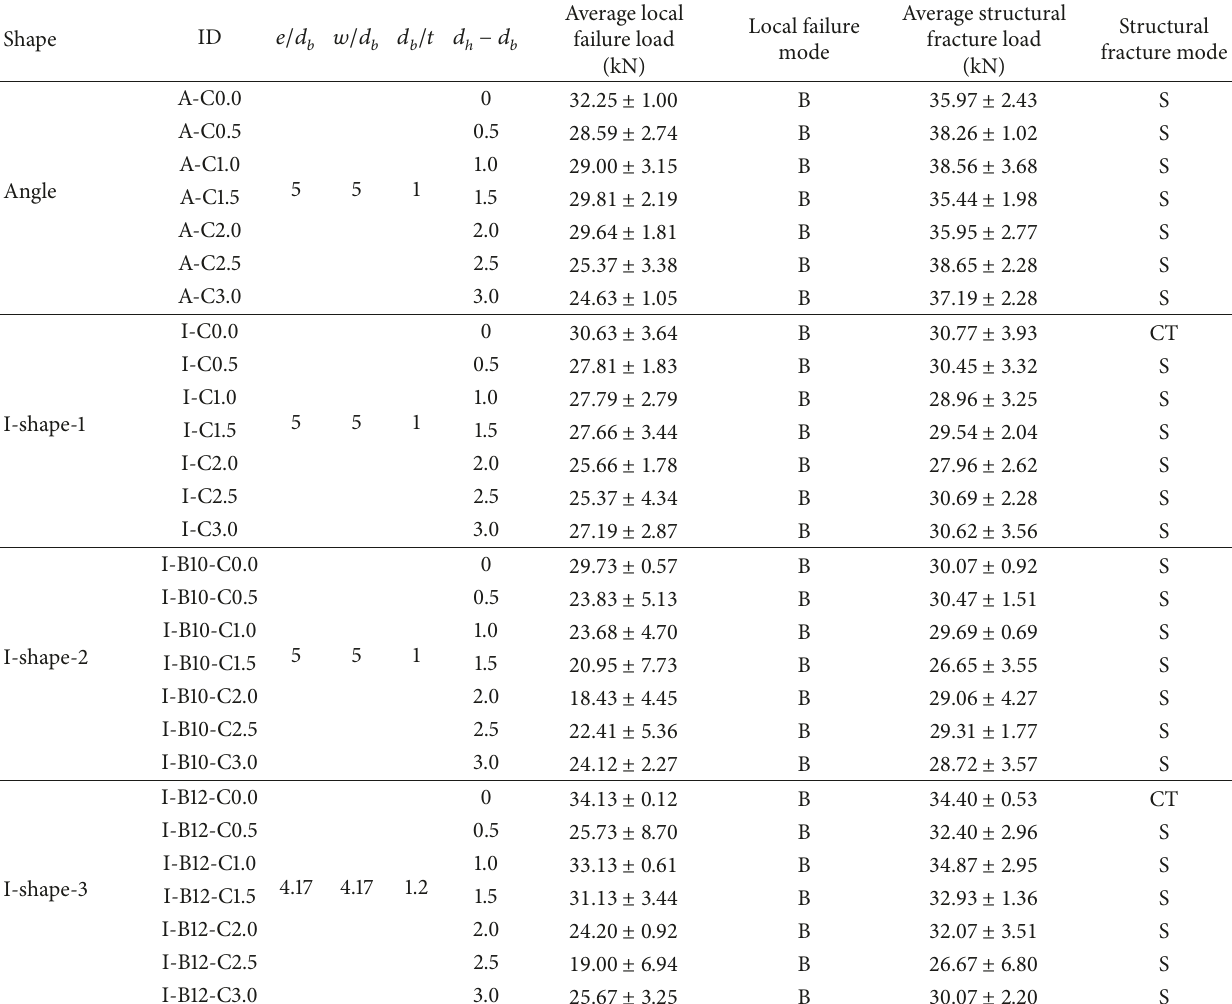
Figure 11: Examples of local failure and structural fracture modes (I-C0.0 specimen). Table 3: Experimental results for PFRP bolted